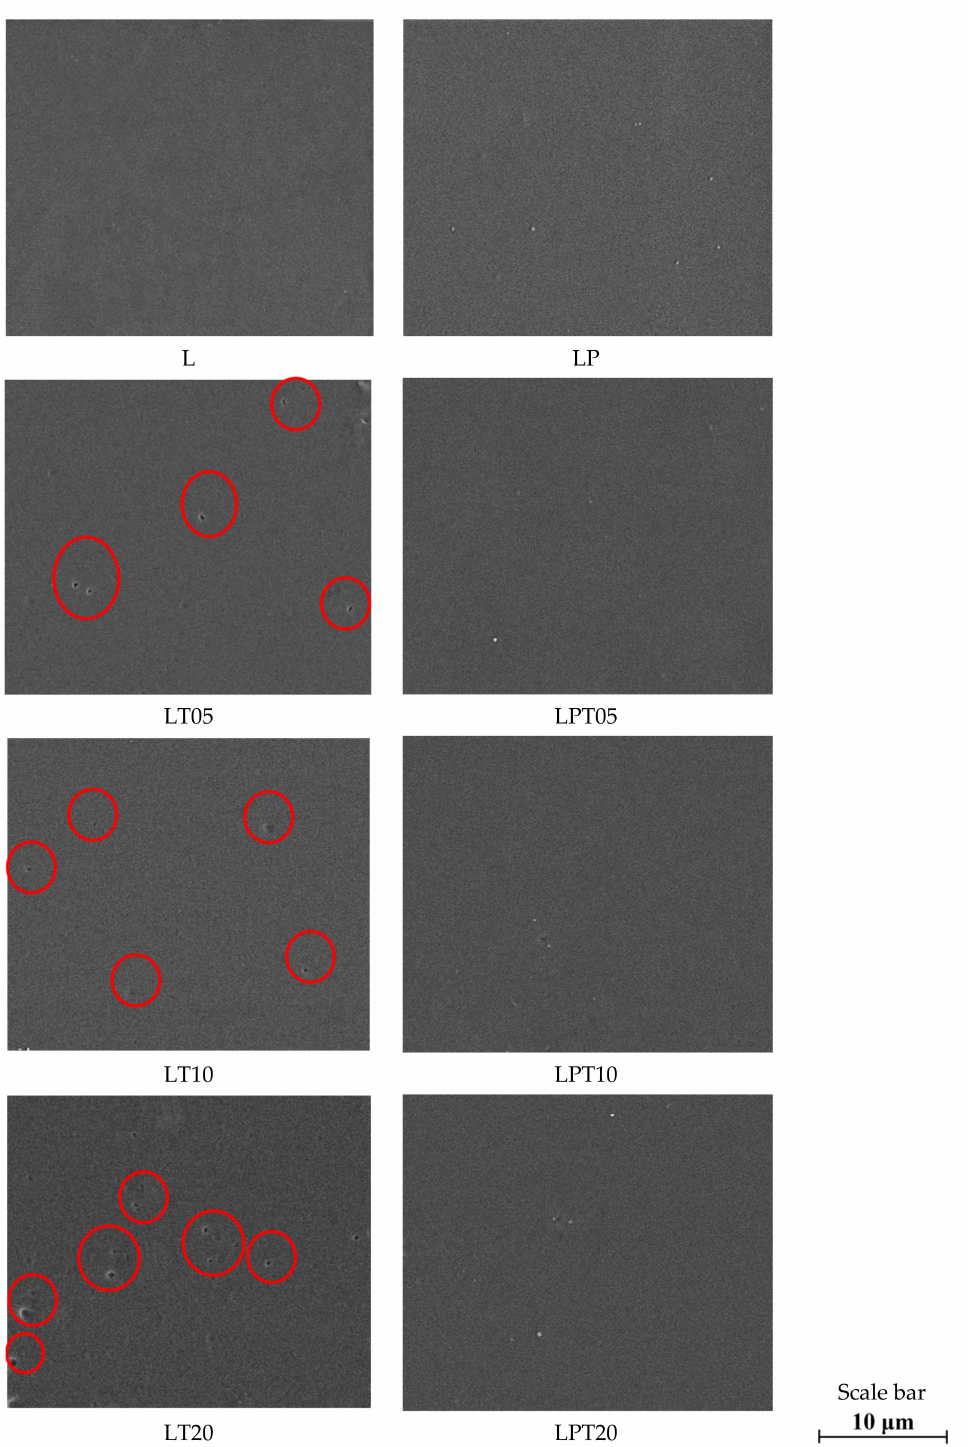
Figure 1. Structure of plasticized or unplasticized films based on polylactide (PLA) with the addition of di ff erent concentrations of TTO (magnification 10,000 ×